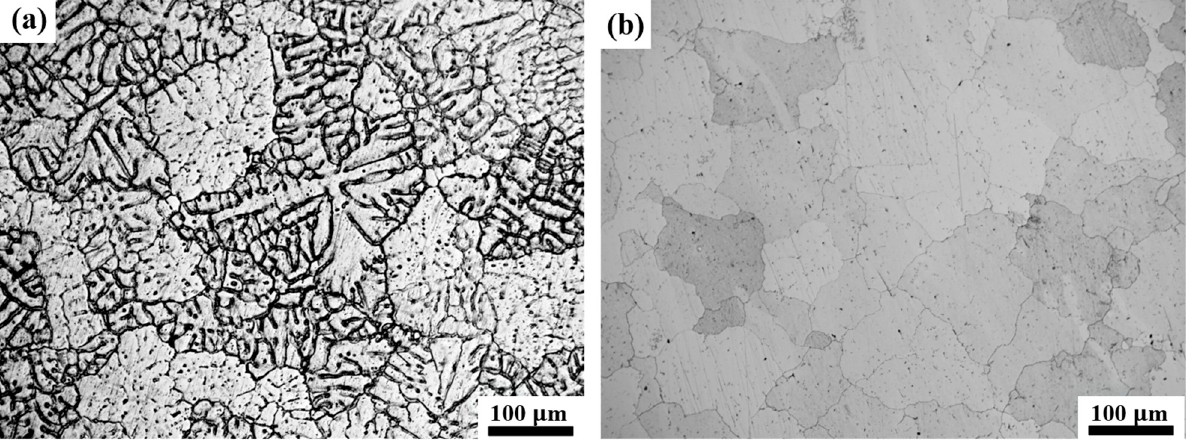
Figure 1. Initial microstructures of the AC and HG AA2195 Al-Li alloys: ( a ) AC 2195 Al-Li alloy, ( b ) HG 2195 Al-Li alloy.